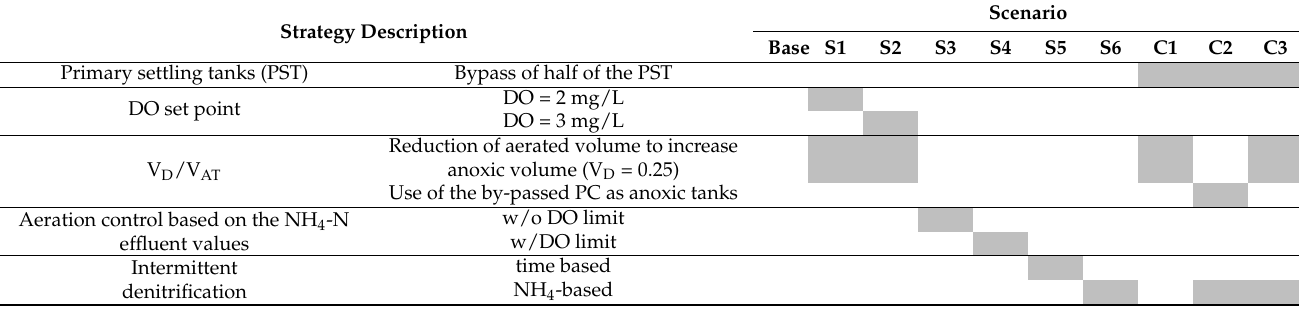
Table 6. Description of the tested